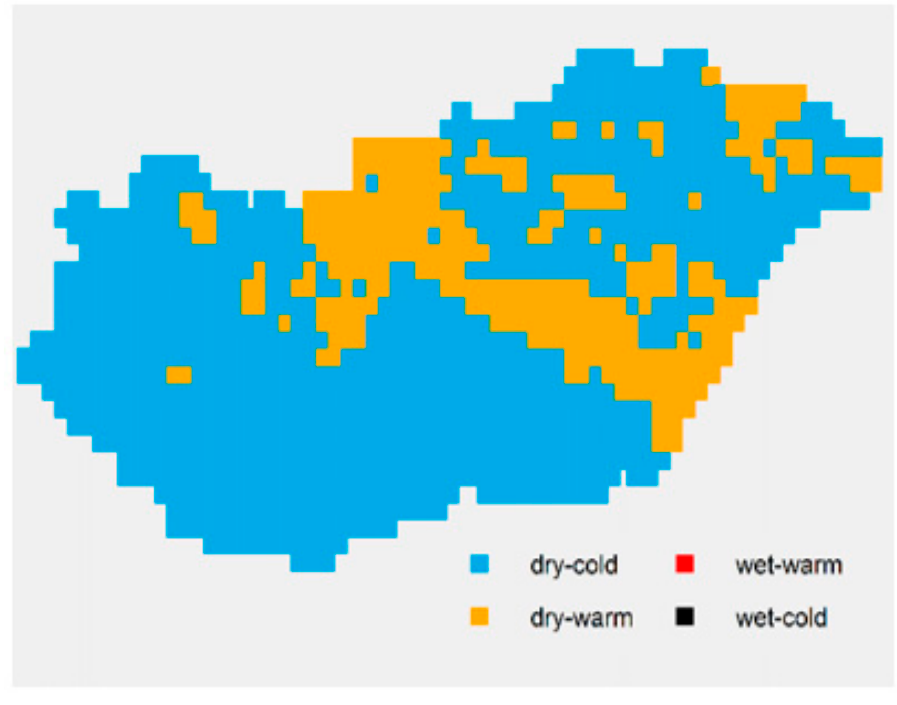
Figure A18. Characteristics of extreme months (October).